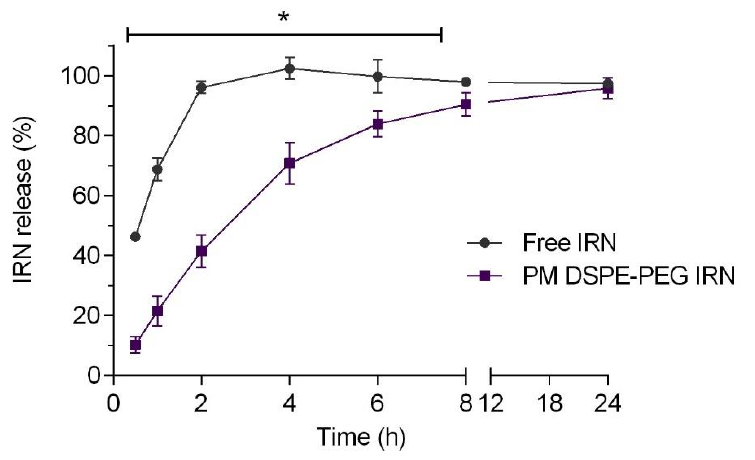
Figure 3. In vitro irinotecan (IRN) release profile from micellar formulations and IRN solution at 37 °C for 24 h. Note: * Represents significant differences ( p < 0.01) between the PM DSPE-PEG IRN and Free IRN. Data are expressed as mean ± SD (n = 3).